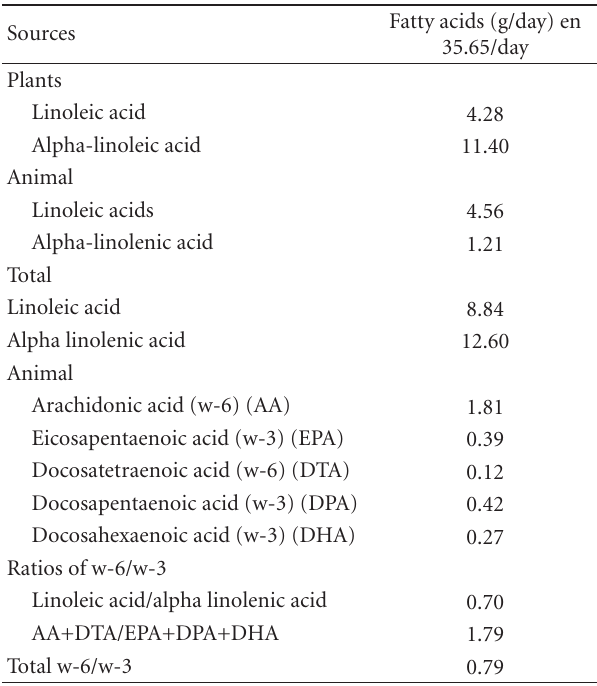
Table 2: Estimated fatty acid consumption in the late Paleolithic period.